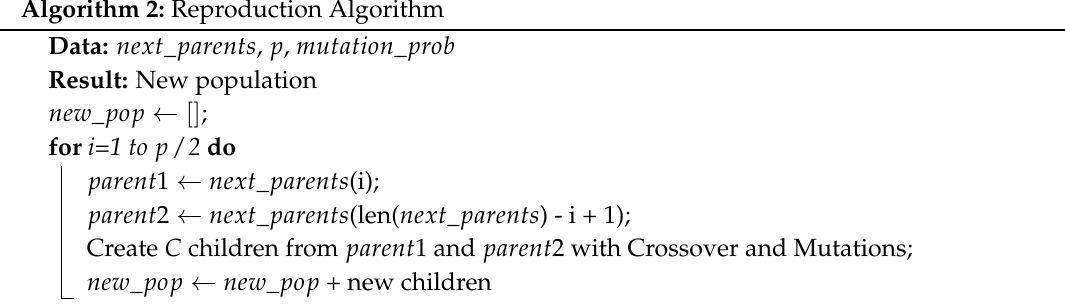
Algorithm 2: Reproduction